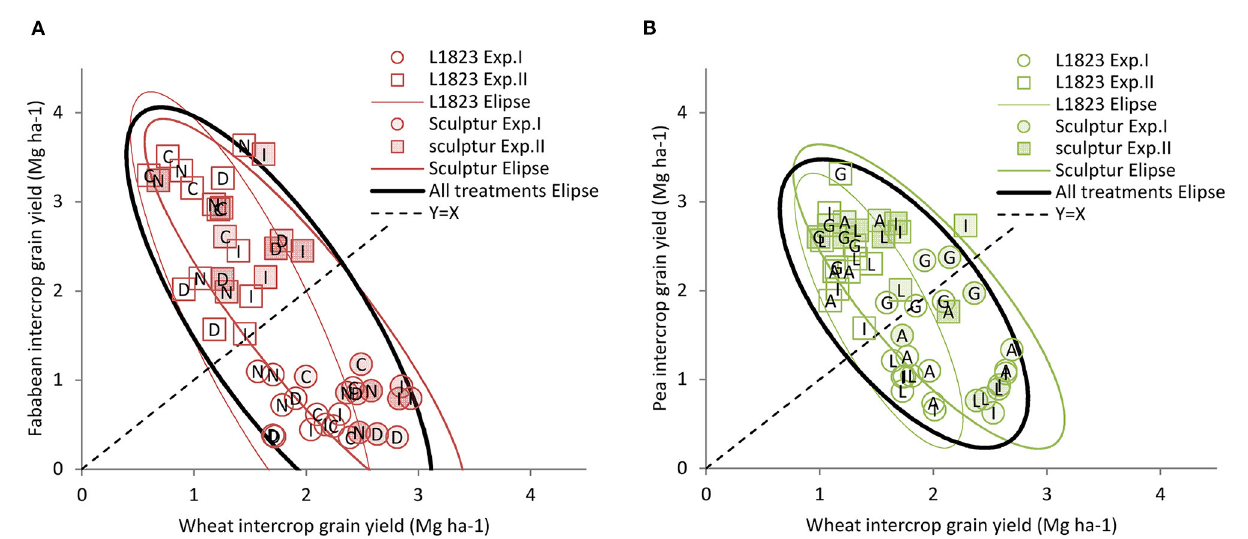
FIGURE 4 | The comparison of legume yield achieved in IC as a function of that of intercropped wheat. Yield achieved in IC by faba bean (A) and pea (B) as a function of that of the intercropped wheat. The symbols correspond to ICF (red), ICP (green), Exp.I (circles), Exp.II (squares), L1823 wheat cultivar (open), and Sculptur wheat cultivar (closed). The ellipses represent the prediction interval at p = 0.90 for ICs with L1823 (thin green or red line), ICs with Sculptur (thick green or red line), and in black for both L1823 and sculptur cultivars. Each point corresponds to a single replicate